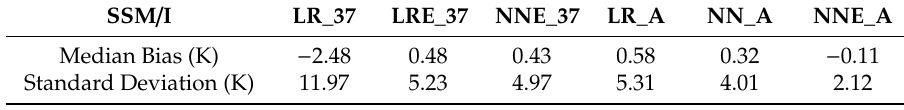
Table 5. Comparison of metrics related to LST estimation for SSM / I observations, globally.